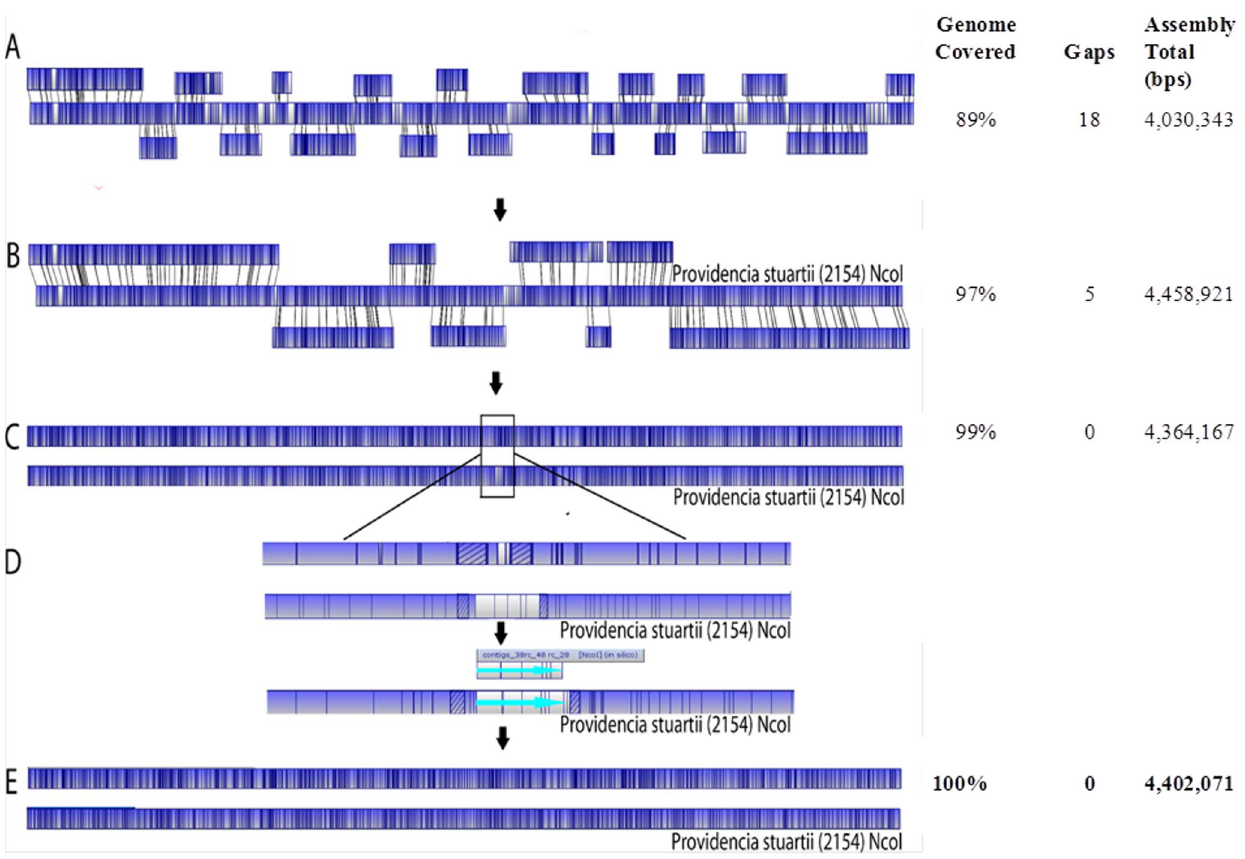
Figure 5. Providenciastuartii MRSN 2154 genome sequence assembly using the WGM-NGS approach. The MapSolver program highlights unaligned regions in white while aligned regions are shaded blue. ( A ) Contig replacement: 19 Roche 454 de novo contigs ( . 500 bp) were aligned to the MRSN 2154 WGRM in the correct orientation and order. Overlaps, redundancies, orientation and unaligned contigs were confirmed and resolved where needed. ( B ) Scaffolding by merging and extension: with the guidance of WGM and the branching structure information (454 contig graph), contigs were progressively joined to form scaffolds. Scaffolds were aligned to the WGRM to examine orientation, order, overlaps and gaps. ( C ) Alignment of first draft to the WGRM: after removal of redundant overlapping sequences, scaffolds were joined to form the first genome draft. ( D ) Correction of mismatches: An unaligned region of approximately 30 kb was identified (shown as white region) and subsequently resolved with the aid of the WGRM and branching structure information is shown in detail in Figure 2. Identified contigs were integrated in the draft. ( E ) Alignment of the complete genome sequence to the WGRM. The WGRM reference was 100% covered with highly similar NcoI restriction pattern.